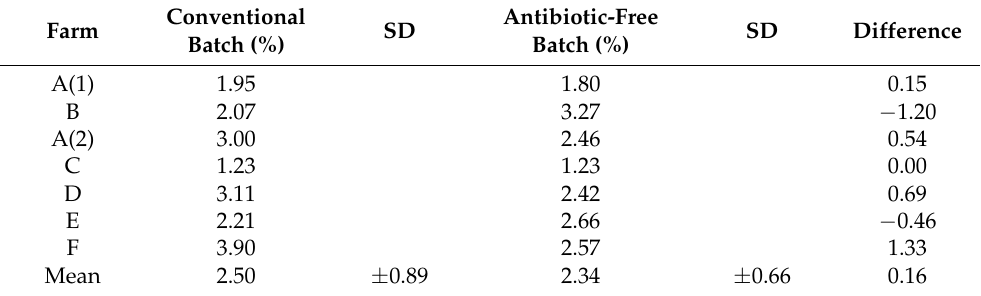
Table 3. Death rate in each pair of batches, including the difference calculated between the conven- tional and antibiotic-free batches. The average death rate in the two groups, with standard deviation (SD), is also